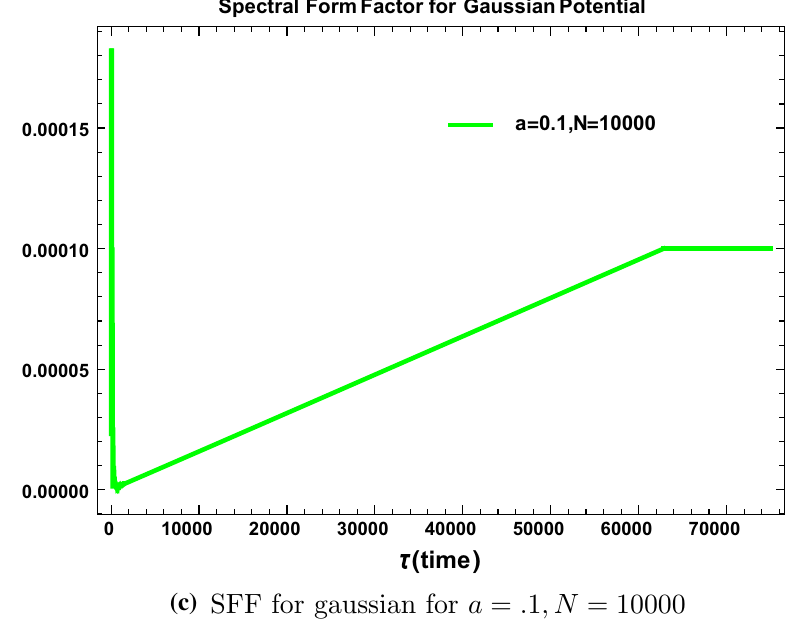
Fig. 24 Time variation of SFF for different N at β = 0. Here we used a scale factor SFF + 0 .